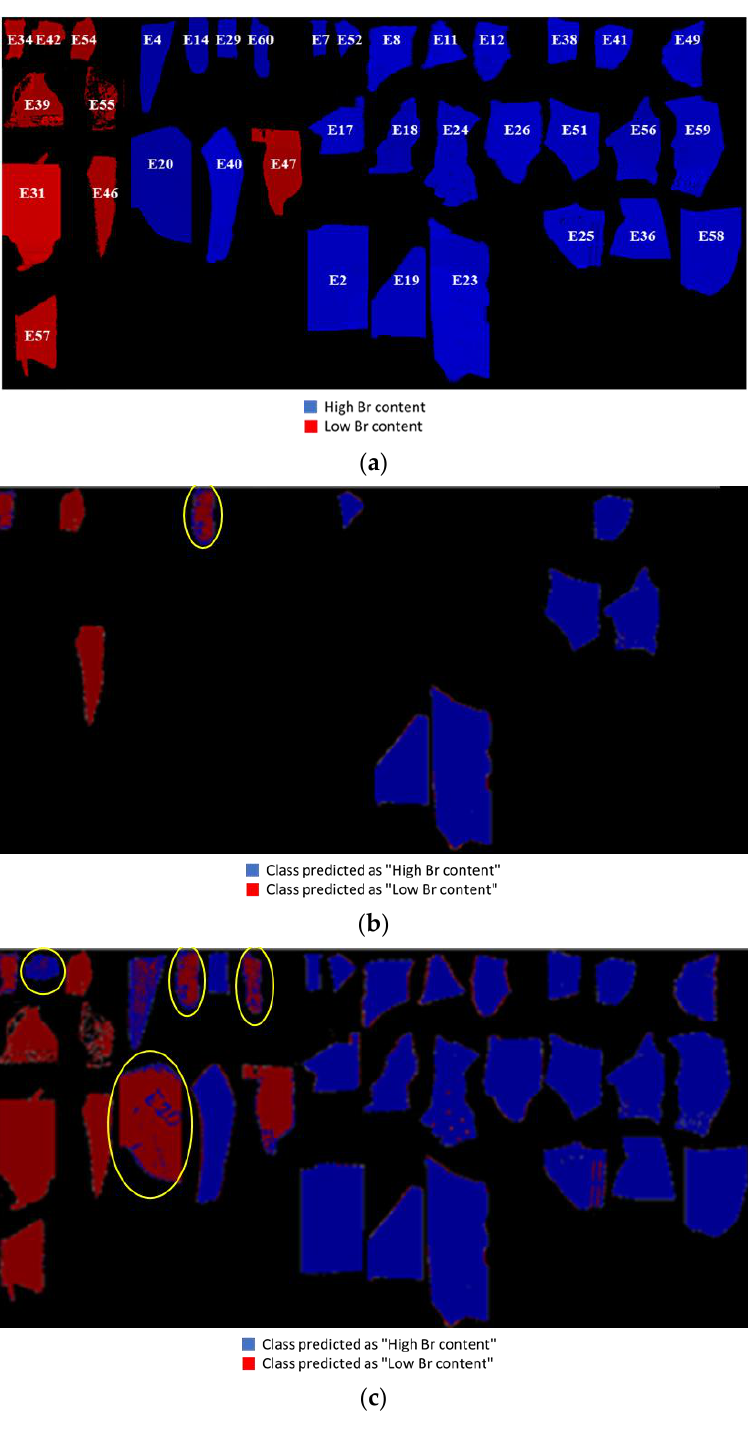
Figure 8. True class membership ( a ) and most probable class prediction for SisuCHEMA XL™ data obtained after the application of PLS-DA model for the validation set ( b ) and the global set ( c ). Blue = “High Br content” class; Red = “Low Br content” class. Samples circled in yellow were incorrectly identified.